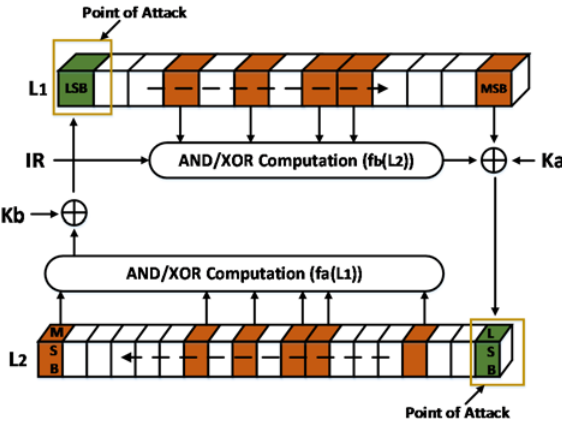
Figure 32. KATAN encryption scheme. Electronics 2017 , 6 , 67